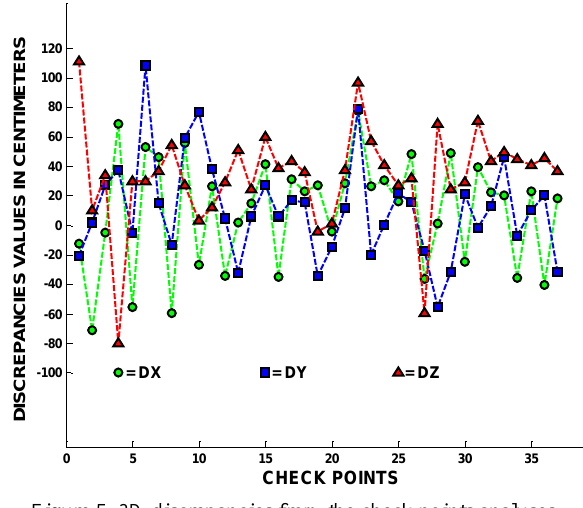
Figure 5. 3D discrepancies from the check points analyses obtained in the ISO experiment using IOP in situ camera